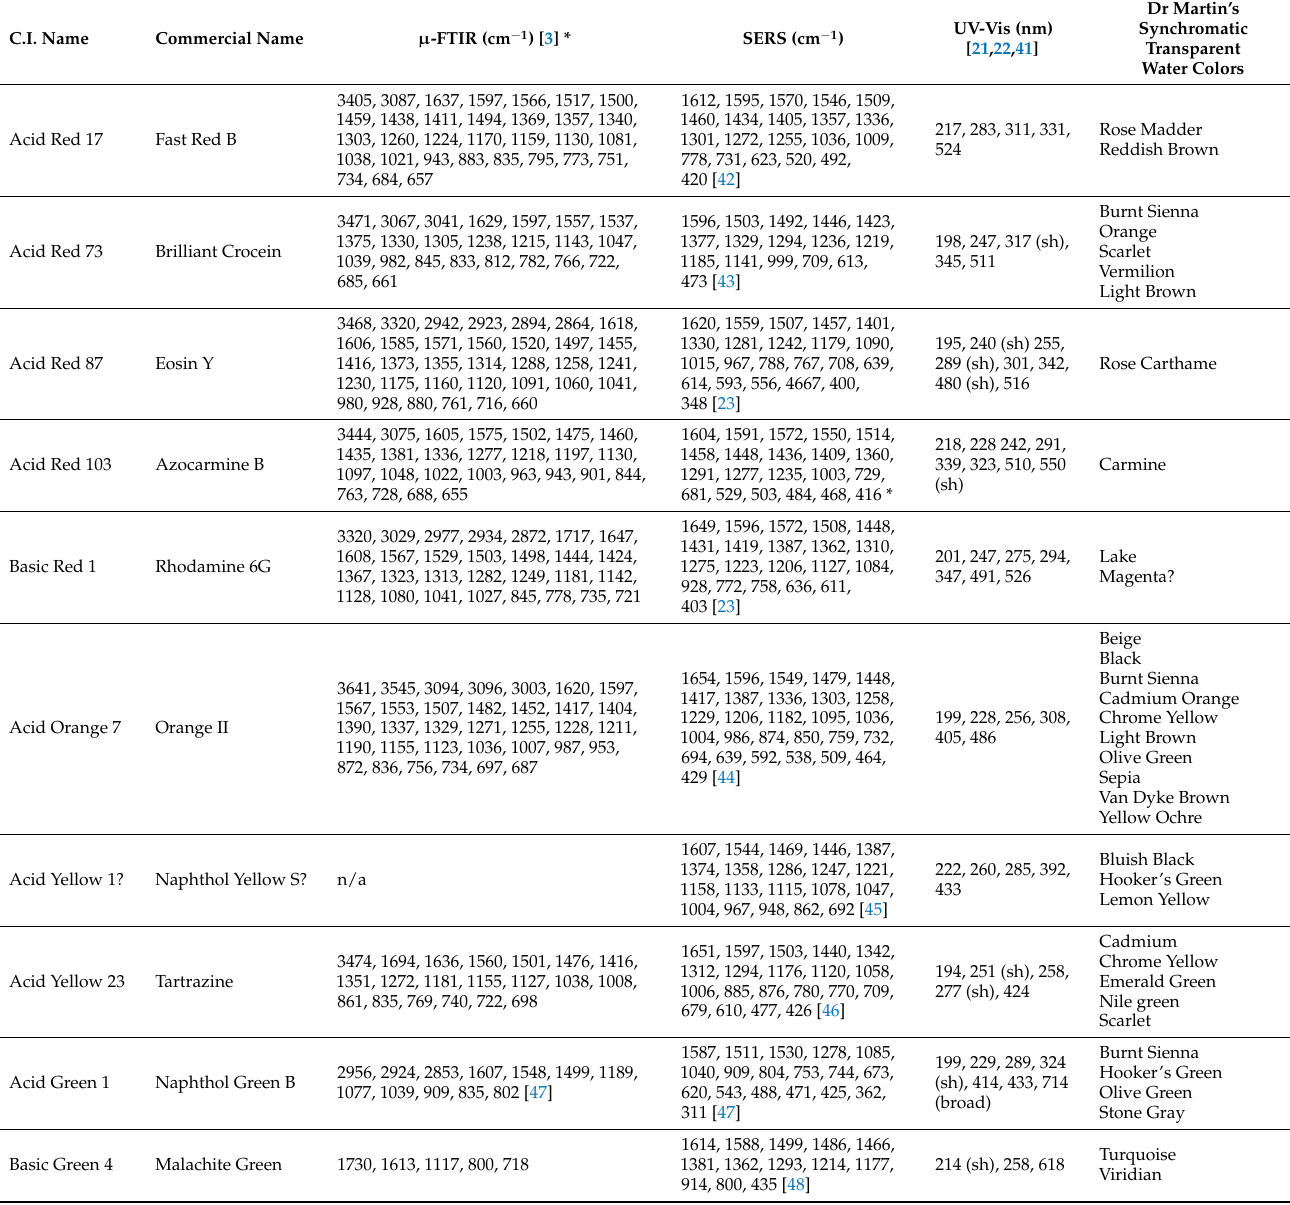
Table 1. The dyes identified in Dr. Ph. Martin’s Synchromatic Transparent Water